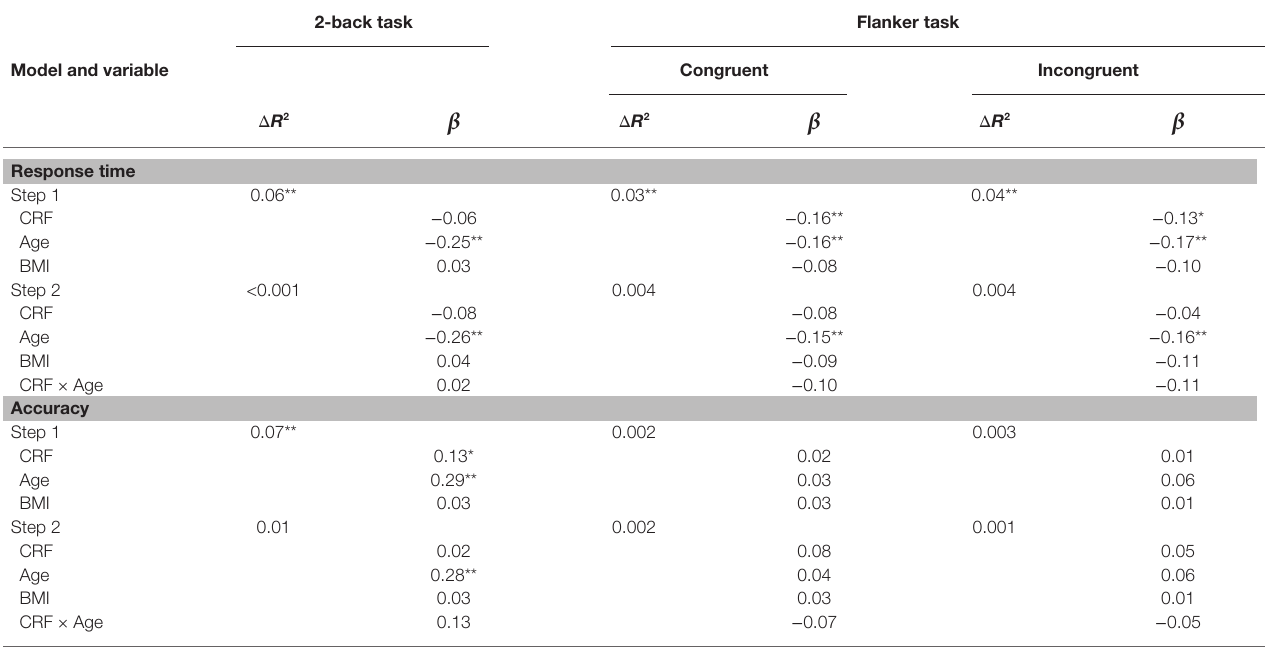
TABLE 2 | Regression analysis for the associations between cardiorespiratory fitness, age, the 2-back task, and the Flanker task.